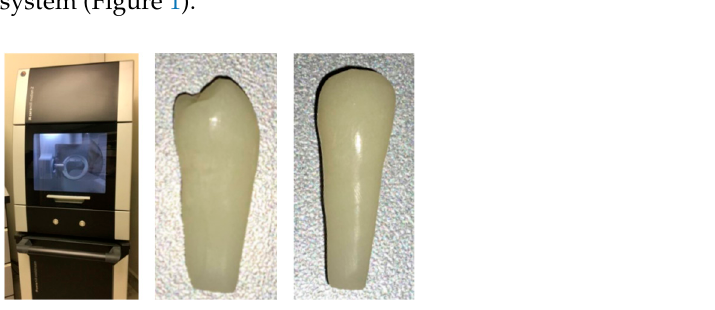
Figure 1. The Ceramill Motion 2 machine and one of the provisional